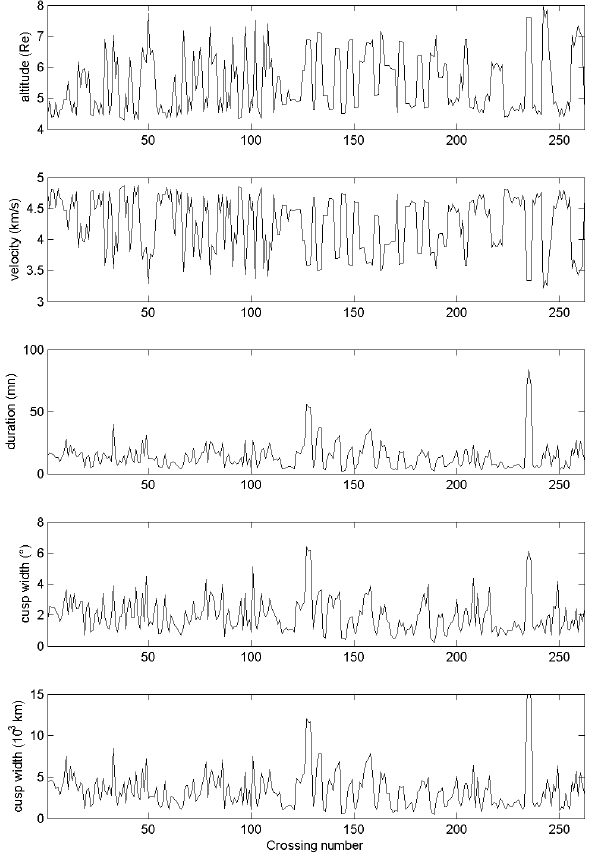
Fig. 5. Panel showing for each crossing, from top to bottom, the al- titude and velocity of the spacecraft, the duration of the cusp cross- ing in minutes, the cusp latitudinal width in degrees (difference be- tween the locations of the poleward and the equatorward bound- aries), and the latitudinal width in thousands of kilometers (duration of the crossings times the velocity of the spacecraft).